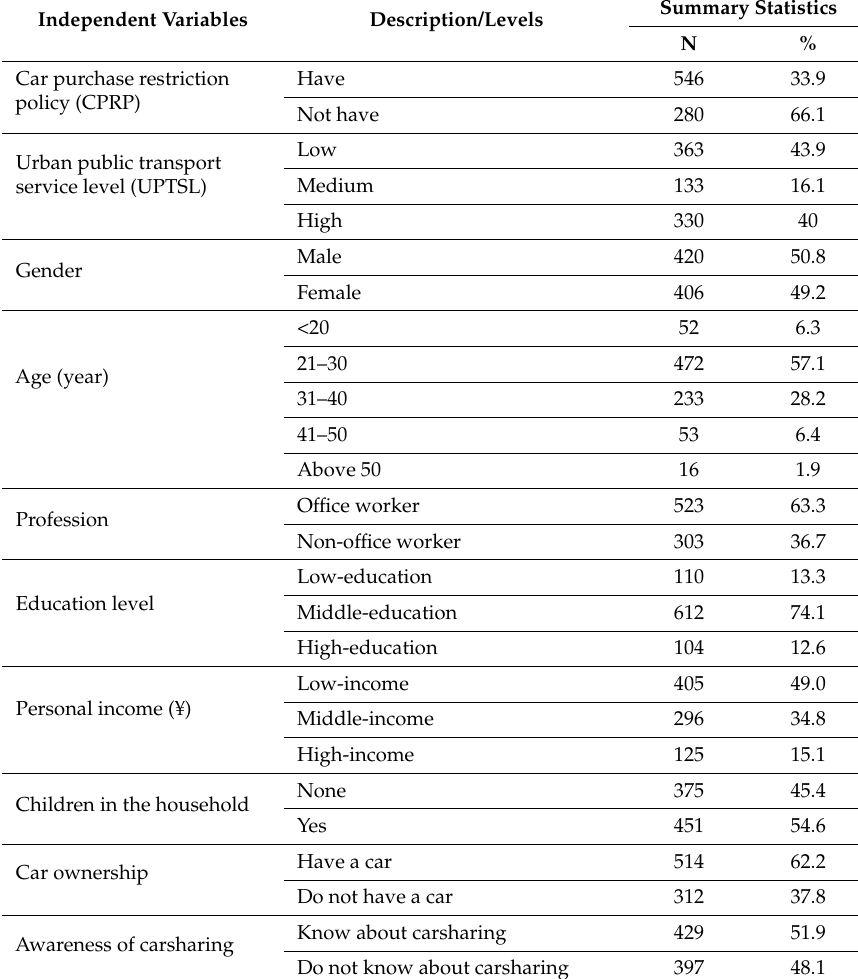
Table 2. Independent variables used in the